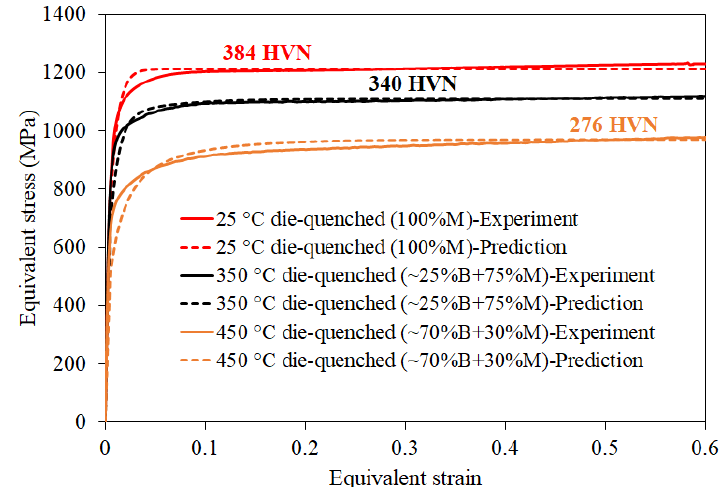
Figure 15. The predicted flow stress-strain response of various die-quenched microstructures of Ductibor ® 1000-AS using the established numerical scheme compared with the experimental tensile- plus-converted shear flow data. Table 8. The values of calibration parameters ( a , b , and c ) of Equation (22) for the martensite carbon content (% C M ) and MMC material parameters ( A , B , and C ).